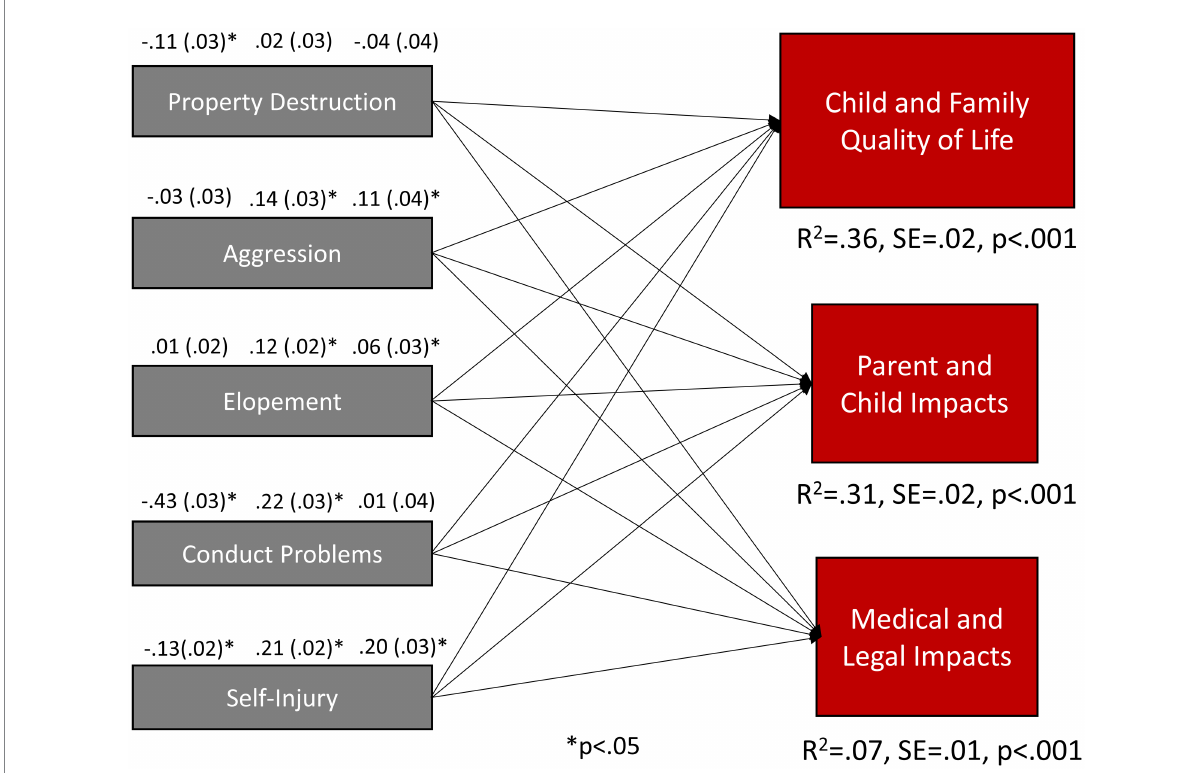
FIGURE 2 Challenging behavior subscales as predictors of child and family quality of life, work/school, and medical/legal functional impacts. The model is just identified. For each challenging behavior subscale, standardized parameters are listed in order starting with CFQL-2, Parent and Child Impacts, and Medical and Legal Impacts. Correlations among challenging behavior subscales ranged from 0.39 to 0.76. Correlations among the CFQL-2 and impact subscales were (CFQL-2 with parent/child impacts r = − 0.41; CFQL-2 with medical/legal impacts r = − 0.09; parent/child impacts with medical/legal impacts r = 0.22). The pattern of residual correlations was consistent with the observed bivariate correlations among these subscales (see Supplementary material 6). Gray boxes are challenging behavior scales serving as predictors, while red boxes are quality of life and impact outcome variables.